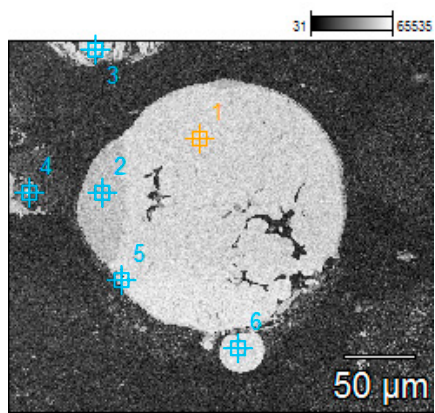
Figure 13. Oxide cap and thin surface oxidation.